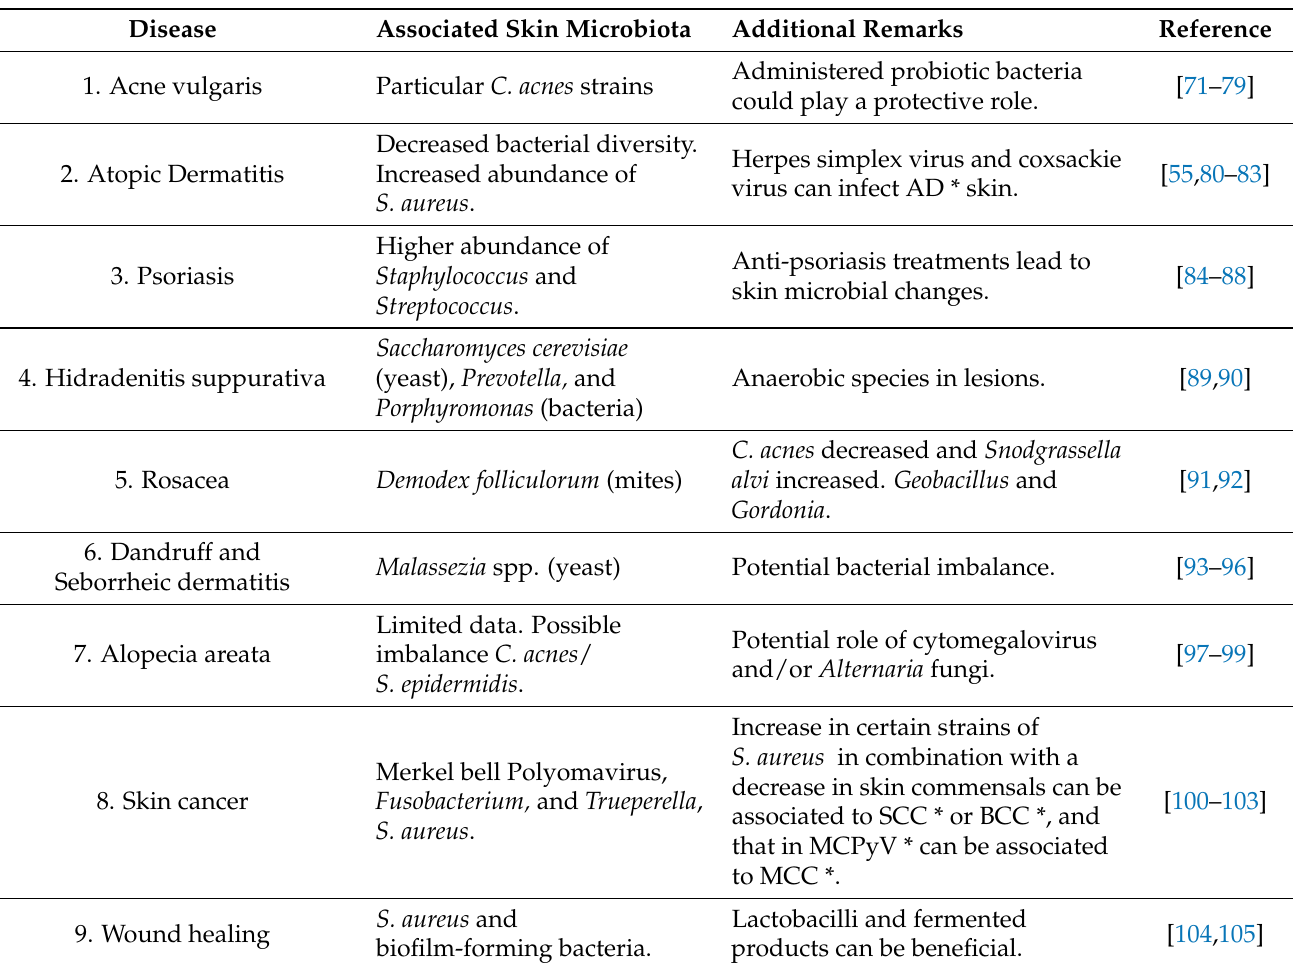
Table 1. Skin microbiota associated with nine common skin disorders.